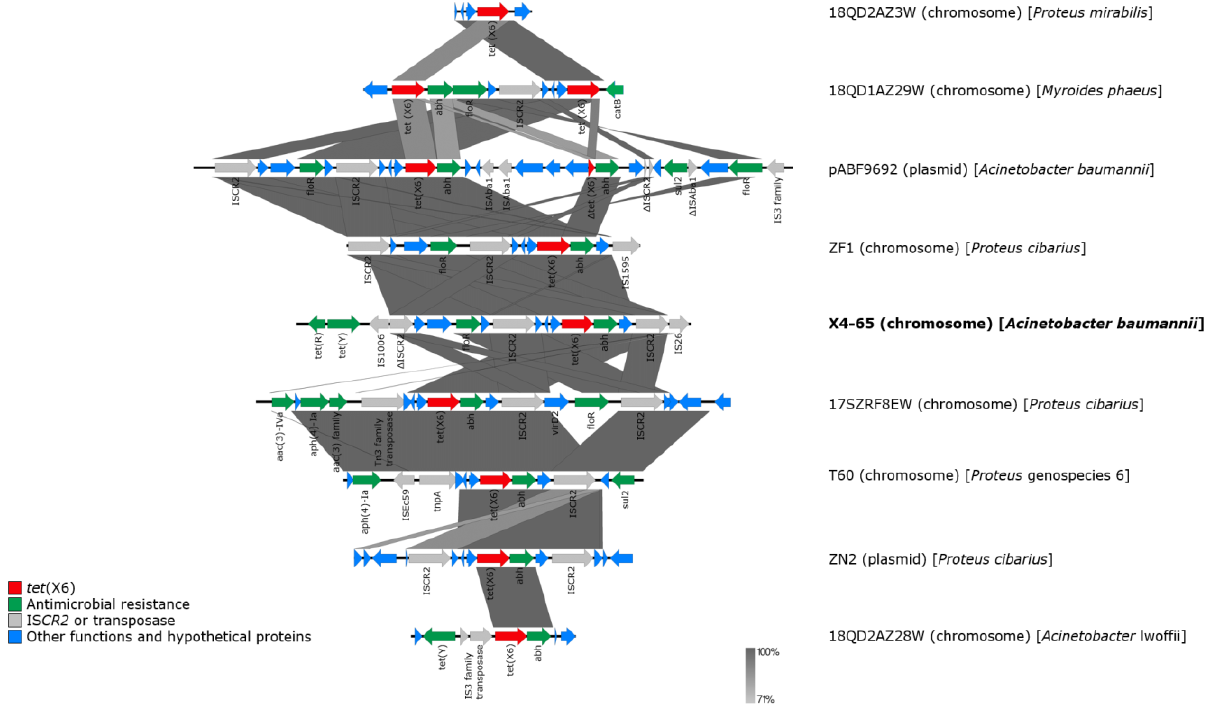
Figure 2. Comparison of tet (X6)-containing regions in different strains. Open reading frames are shown as arrows. Comparative analysis of DNA identity was performed using Easyfig 2.2.2. The tet (X6) genes are colored in red, and the other genes are colored according to their annotated functions: Green, antimicrobial resistance genes; grey, IS CR2 or transposase-encoding genes; blue, other functions and hypothetical protein-encoding genes.